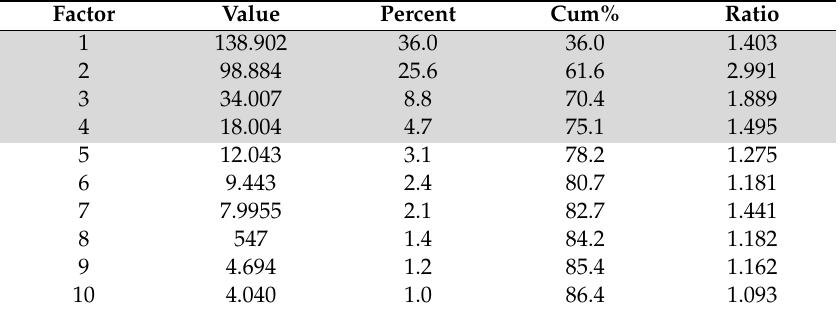
Table 1. Results of the Principal Component Analysis (PCA) for the first ten